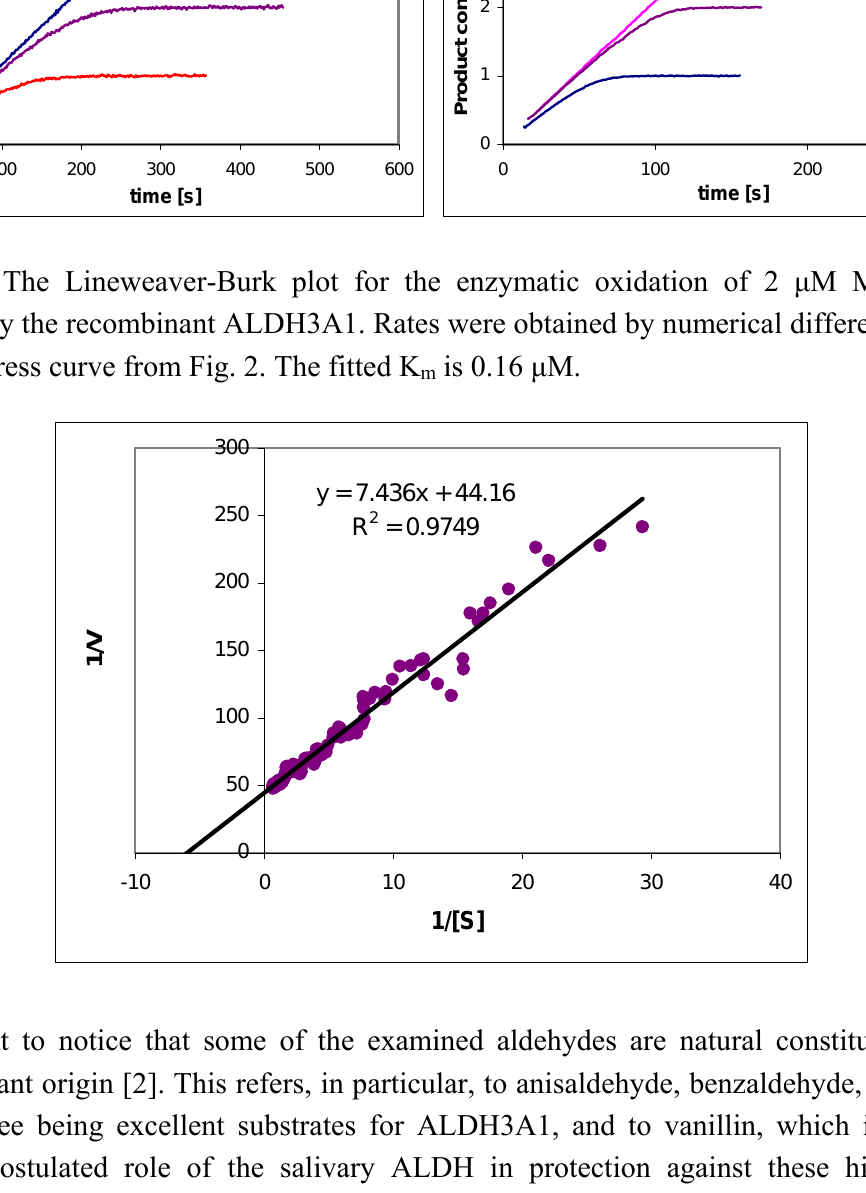
Figure 2. Reaction progress curves, recorded fluorimetrically, for enzymatic oxidation of 2-naphthaldehde (left) and MONAL (right) with the recombinant ALDH3A1 as catalyst. Initial naphthaldehyde concentrations were 5, 2 and 1 μ M. Concentration of NAD + was 100 μ M.